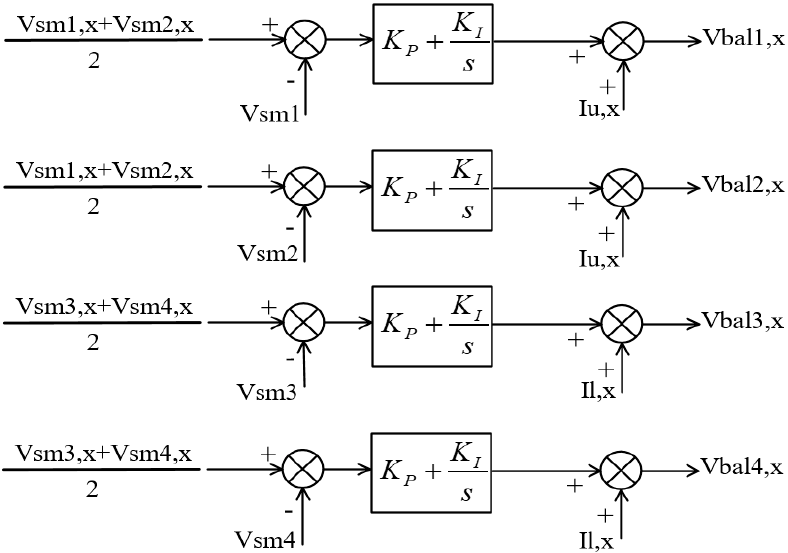
Figure 9. A block diagram of the implemented SM capacitor voltage balancing controller.